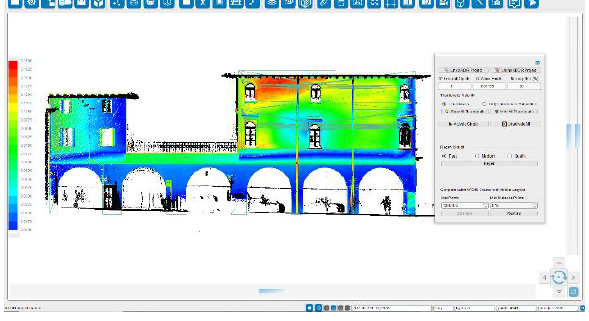
Figure 13. External wall: new scale colours for HBIM vs TLS.